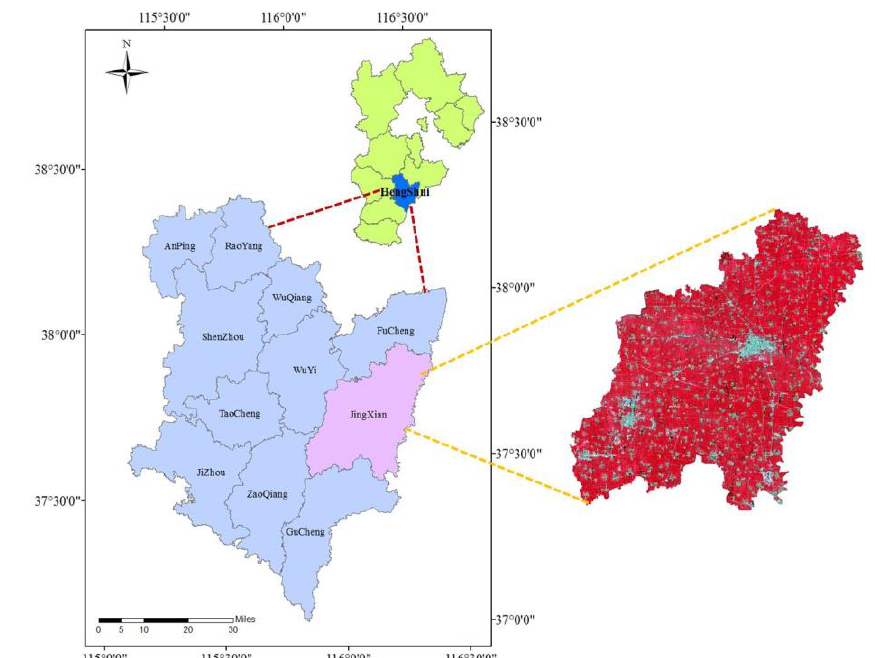
Figure 1. Location map for study area inHengshui City, Hebei Province, China